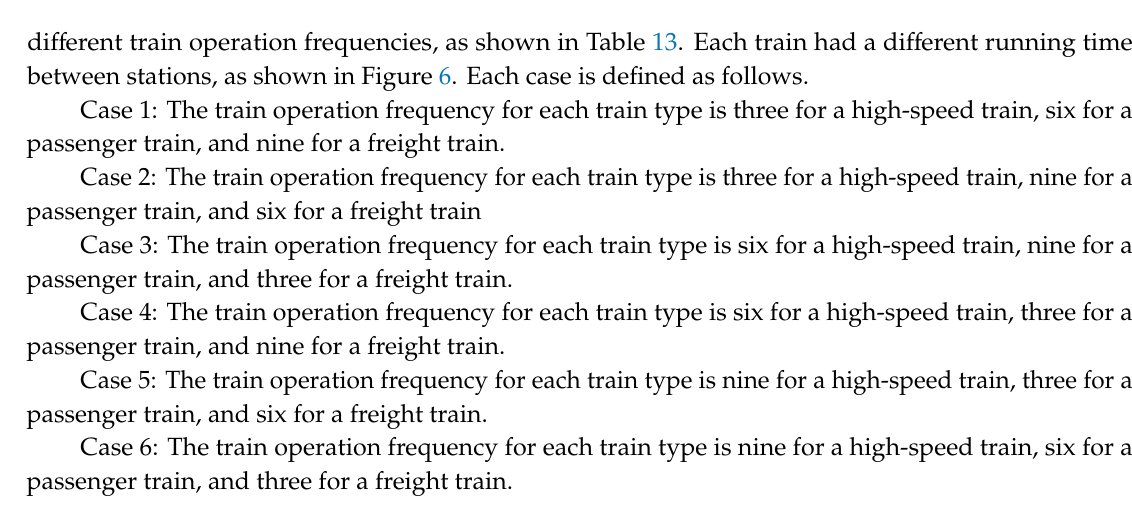
Table 13. Train operation frequencies in di ff erent simulation cases.